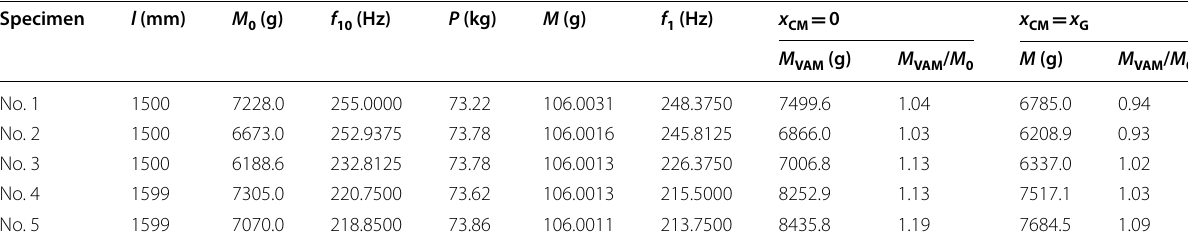
Table 2 Accuracy of VAM (vibration test for the pile model)